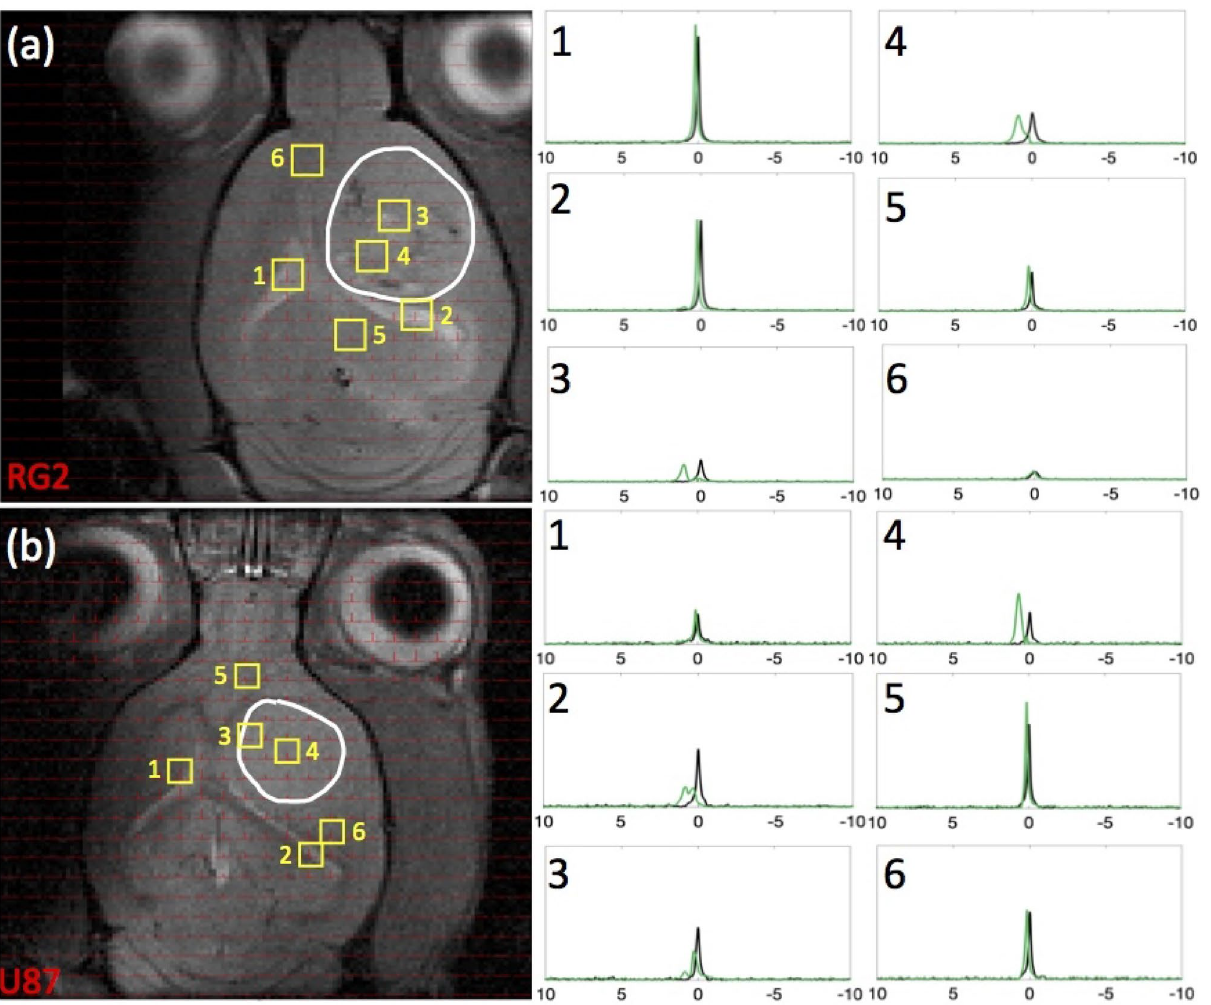
Figure 3. Comparison of 23 Na peak separation in rats bearing RG2 and U87 tumors. For rats bearing an ( a ) RG2 and ( b ) U87 tumor, the tumor boundary is outlined in white, with voxels of interest indicated in yellow squares (with numbers), and spectra acquired before and after TmDOTP 5− delivery shown in black and green, respectively. Tumor voxels 3 and 4 in ( a ) RG2 and ( b ) U87 tumor rats exhibited a fair amount of peak separation due to the leaky BBB. Na + b shift was consistently around 2 ppm, and Na + i shift was at 0 ppm, whereas Na + e shift in the tumor was in the range 0.5–1 ppm. Healthy tissue voxels 5 and 6 in ( a ) RG2 and ( b ) U87 tumor rats were slightly shifted in the downfield direction, suggesting the paramagnetic effects of TmDOTP 5− reach the extracellular space even with limited extravasation. Ventricular voxels 1 and 2 in ( a ) RG2 and ( b ) U87 tumor rats displayed a single unshifted Lorentzian peak before and a shifted Lorentzian peak after TmDOTP 5− injection. This is attributed to the dominant 23 Na signal contribution in the ventricles coming from cerebrospinal fluid (CSF), which contains free (i.e., unbound) aqueous Na + . The position of the shifted ventricle peak coincided with the Na + e peak position in other regions of the brain. This agrees with